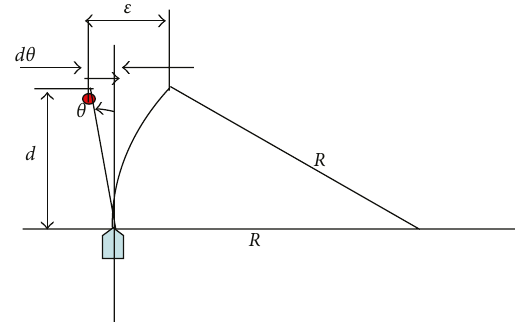
Figure 7: Position of preceding vehicle during cornering without considering the sideslip